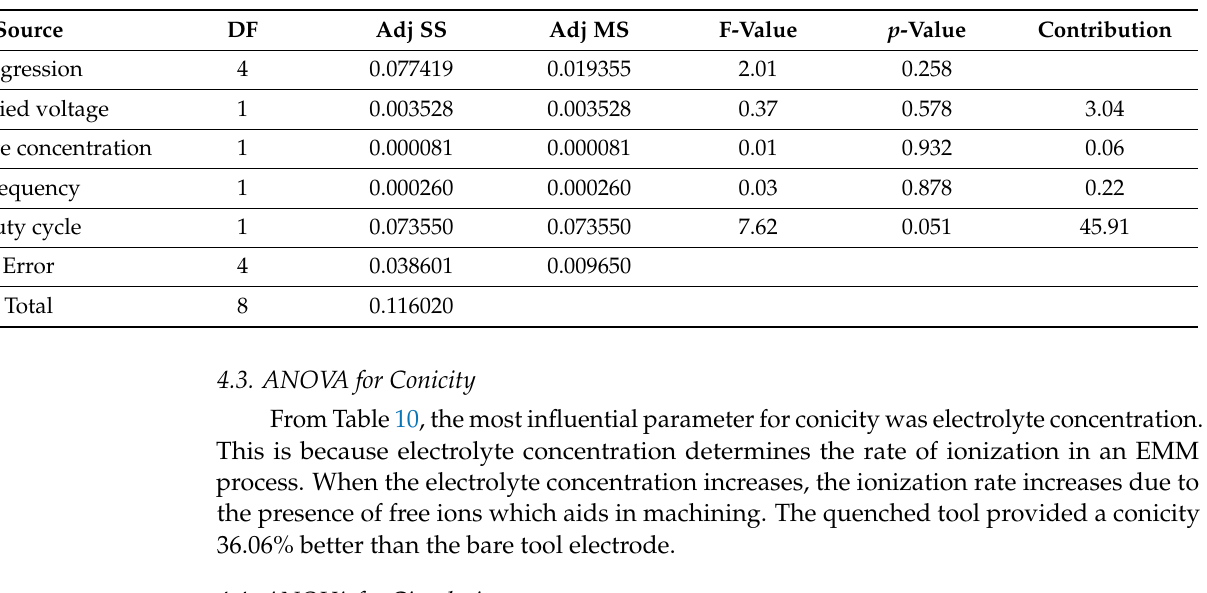
Table 9. ANOVA of overcut for annealed